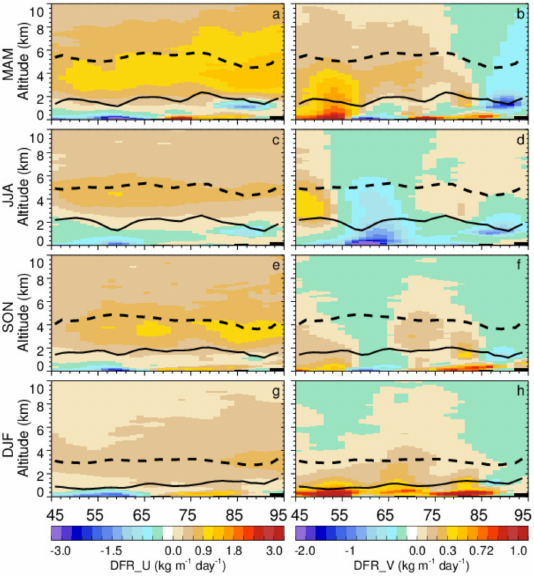
Figure 5. Same as the Figure 4, but for the northern portion of the regions (40–55 ◦ N) in ( a , b )